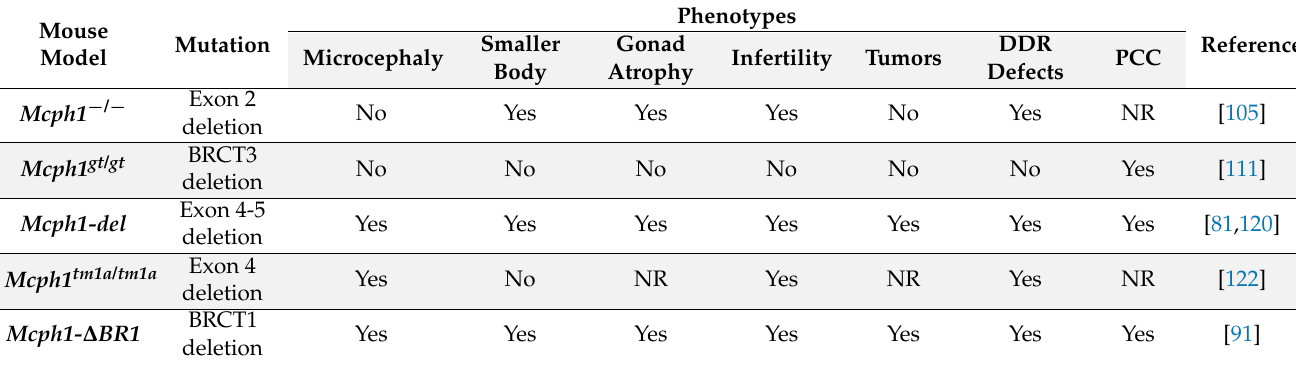
Table 2. Summary of MCPH1 mouse